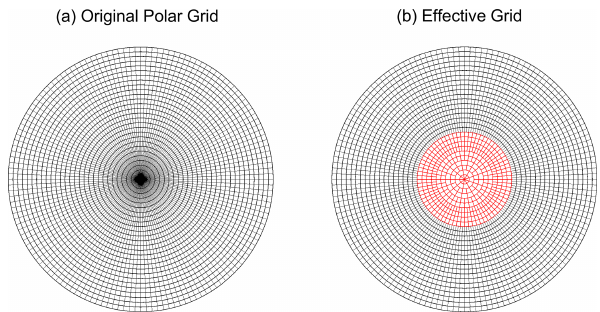
Figure 1. The (a) original and (b) effective 2 . 5 ◦ × 2 . 5 ◦ TIEGCM polar longitude–latitude grid. For example, the 144 azimuthal cells in the most inside (highest latitude) grid (a) have been grouped into 9 effective cells (chunks), with 16 original cells in each chunk. In the effective grid, the numbers of chunks from inside to outside are 9, 9, 18, 18, 36, 36, 72, 72, 72, and